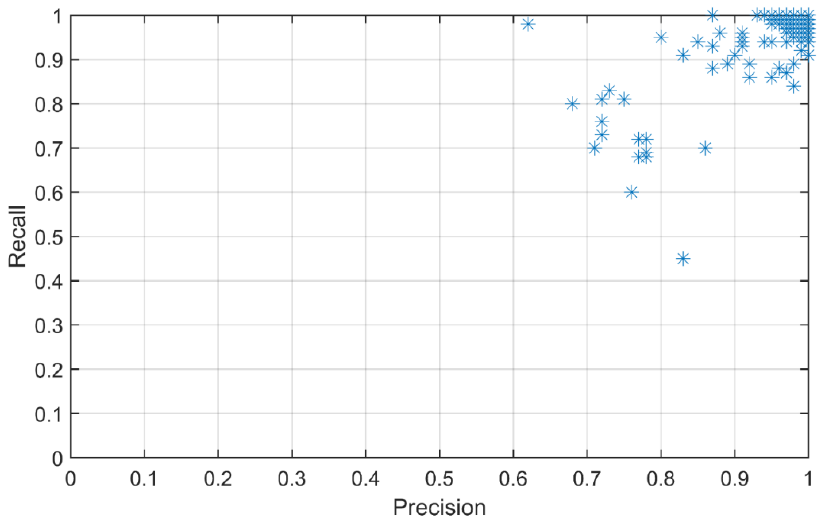
Figure 6. Precision–recall plot for all safety cases.